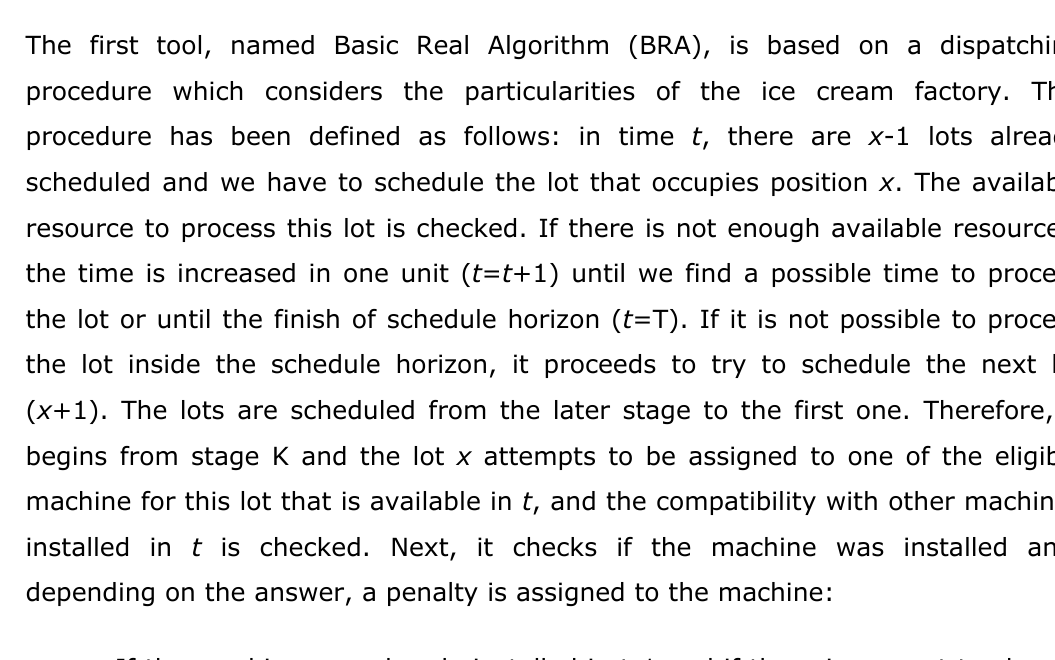
Table 1. “Implemented heuristics”. Source: